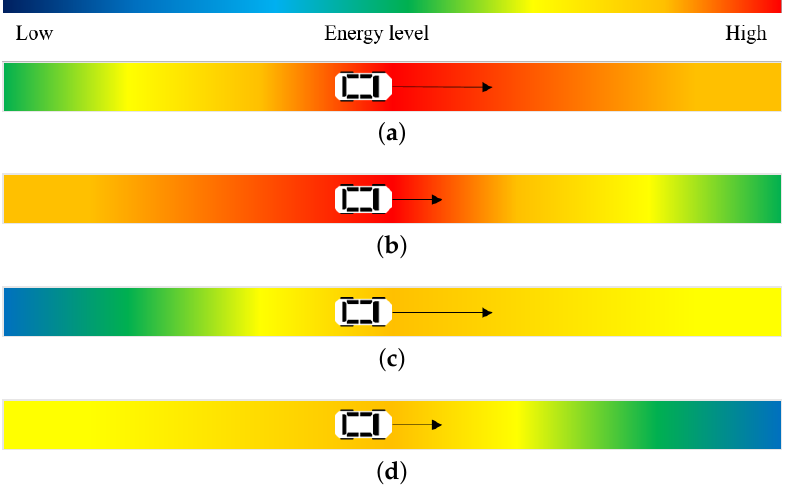
Figure 5. Aspects of potential fields through the proposed method: ( a ) shows the potential field when the vehicle is rapidly accelerated. In contrast, ( b ) represents the distribution when the vehicle is rapidly decelerated. ( c ) shows the potential field when the vehicle is slightly accelerated. ( d ) represents the distribution when the vehicle is slightly